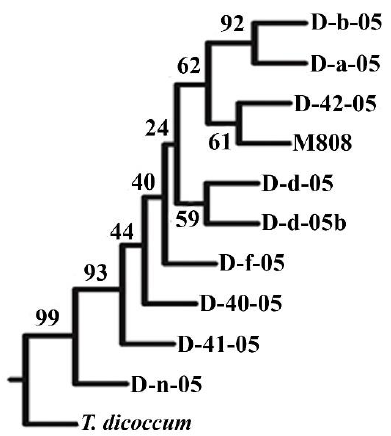
Figure 1. UPGMA-dendrogram of genetic similarity of alloplasmic wheat lines according to simple sequence repeats (SSR) analysis. Designations of parental forms: T. aestivum cv. Mironovskaya 808 (M808), T. dicoccum .